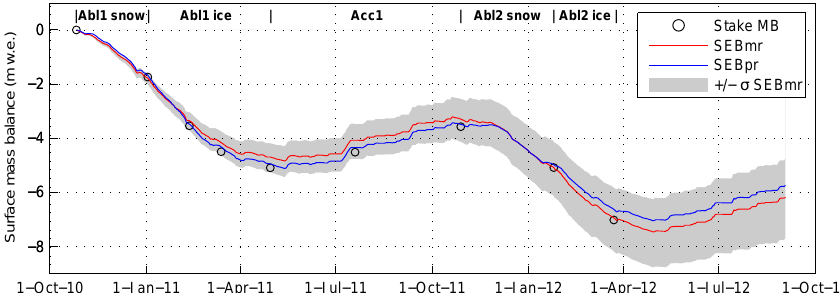
Figure 4. Accumulated SMB during the measurement period as modelled by the reference runs of SEBmr and SEBpr. The points give observed mass balance from periodic stake and snow-pit measurements. The SMB for selected ablation and accumulation periods (shown as Abl1 snow etc.) are given in Table 4. The shaded envelope shows ± 1 standard deviation from the mean of SEBmr, calculated using Monte Carlo simulations (see Sect. 2.4 for details).